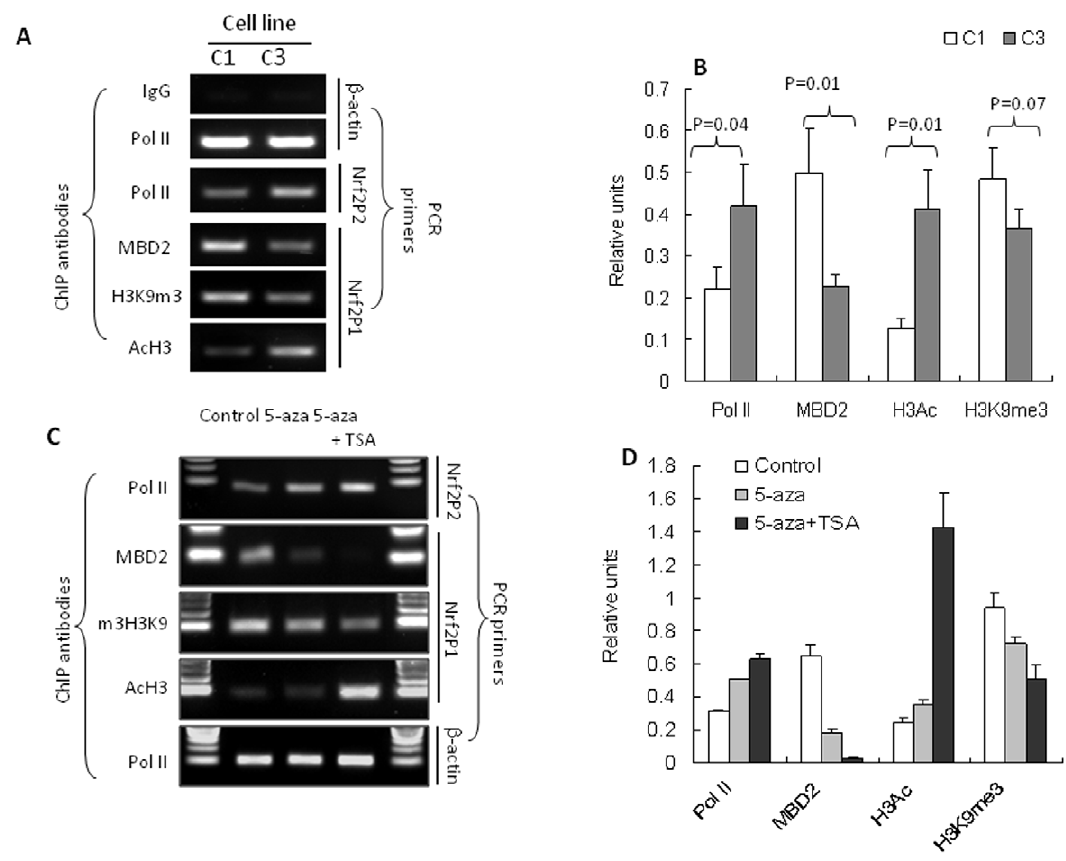
Figure 3. Hypermethylated CpG island was associated with MBD2 binding and histone modifications and 5-aza/TSA treatment reversed the association. ( A ) ChIP assay was performed to detect the binding of indicated proteins to specific regions of Nrf2 gene cross-linked and immunoprecipitated from TRAMP C1 and C3 cells. The results from 3 independent experiments were quantified by densitometry as shown in ( B ). ( C ) TRAMP C1 cells were treated with vehicle, 5-aza or 5-aza + TSA as described, then the cells were subjected to ChIP assay. The results from 2 independent experiments were quantified by densitometry as shown in ( D ). ChIP assays were performed as described in Material & Methods using antibodies against Pol II, MBD2, H3K9m3 and AcH3. 3 sets of ChIP primers were used (Table S2), with Nrf2P1 covers the first 5 CpGs ( 2 1190 to 2 1092) in the CpG island and Nrf2P2 covers a region close to TSS ( 2 62 to + 20). Nonspecific IgG was employed as a negative control and binding of Pol II to b -actin promoter was used to verify the efficiency of ChIP assay. The experiments were repeated at least twice with similar